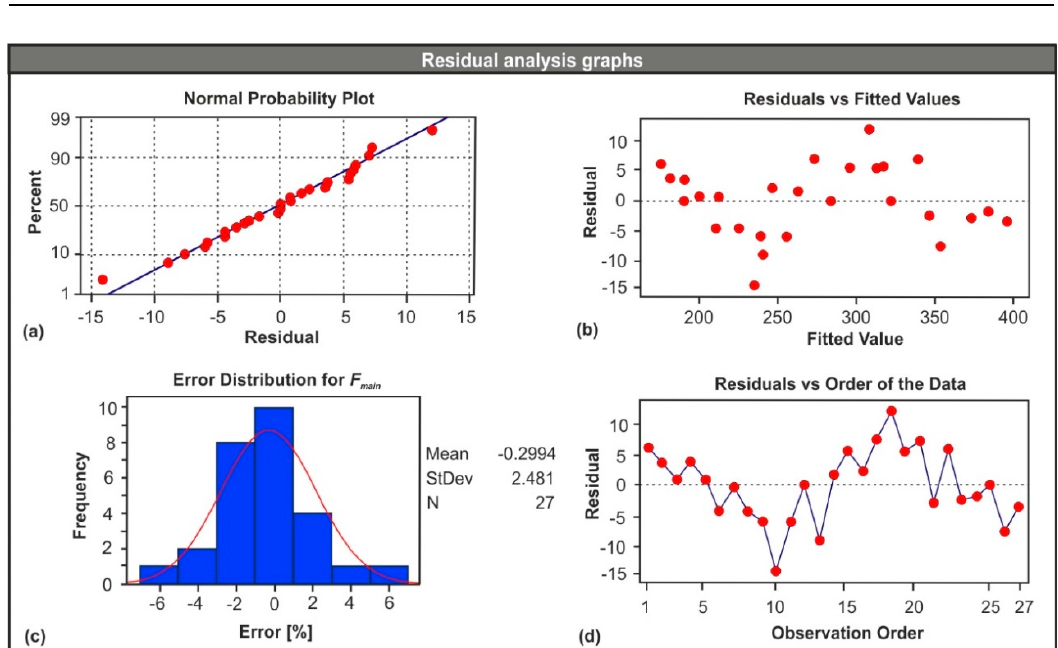
Figure 7. Residual analysis graphs: ( a ) probability plot, ( b ) residuals versus fitted values, ( c ) error histogram, and ( d ) residuals versus order.